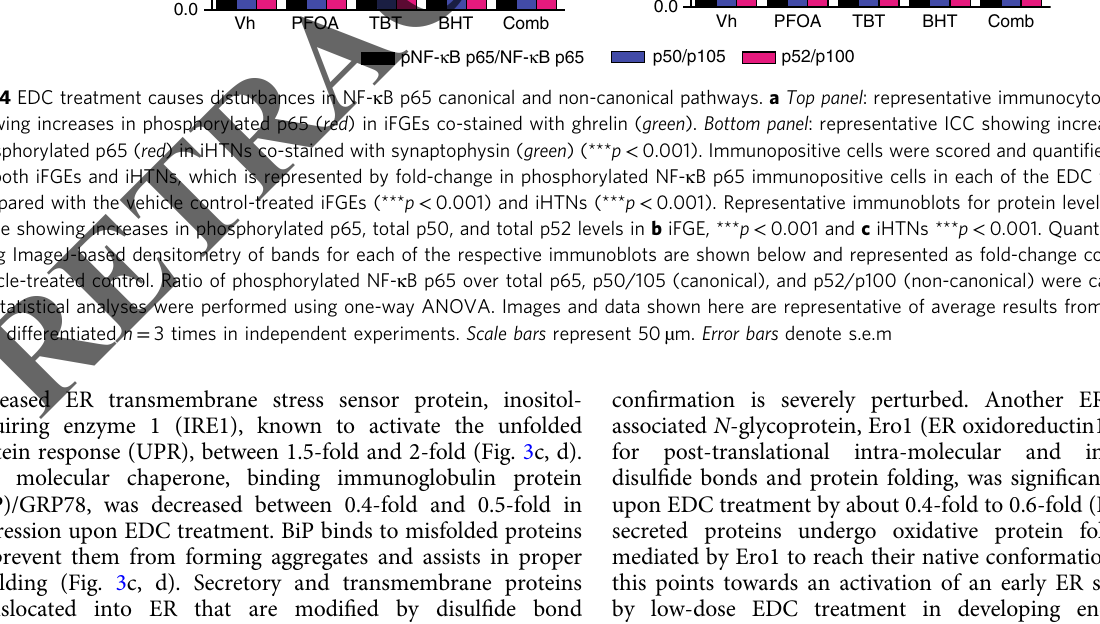
requiring enzyme 1 (IRE1), known to activate the unfolded protein response (UPR), between 1.5-fold and 2-fold (Fig. 3c, d). The molecular chaperone, binding immunoglobulin protein (BiP)/GRP78, was decreased between 0.4-fold and 0.5-fold in expression upon EDC treatment. BiP binds to misfolded proteins to prevent them from forming aggregates and assists in proper refolding (Fig. 3c, d). Secretory and transmembrane proteins translocated into ER that are modi fi ed by disul fi de bond formation, amino-linked glycosylation and folding, require BiP to fold properly. When BiP levels decrease, native protein folding